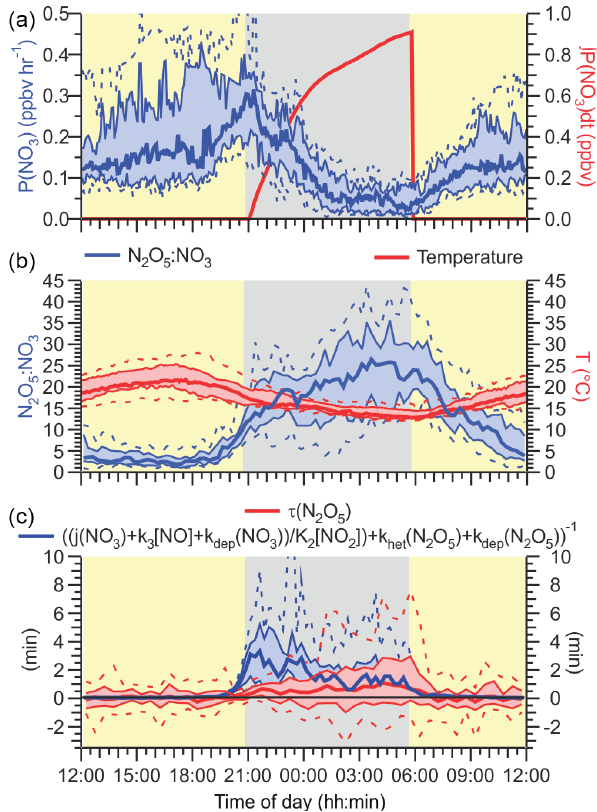
Figure 8. (a) NO 3 production rate P (NO 3 ) = k 1 [NO 2 ][O 3 ] as a function of time of day. The red line is the total amount NO 3 gen- erated since sunset, P (NO 3 ) d t . (b) Equilibrium ratio of N 2 O 5 to NO 3 calculated by multiplying the temperature-dependent equilib- rium constant, K 2 , with the NO 2 concentration, [NO 2 ] (left axis), and air temperature (right axis). (c) Steady-state lifetime of N 2 O 5 (left axis) and upper limits calculated using Eq. (3) (right axis) as functions of time of day.